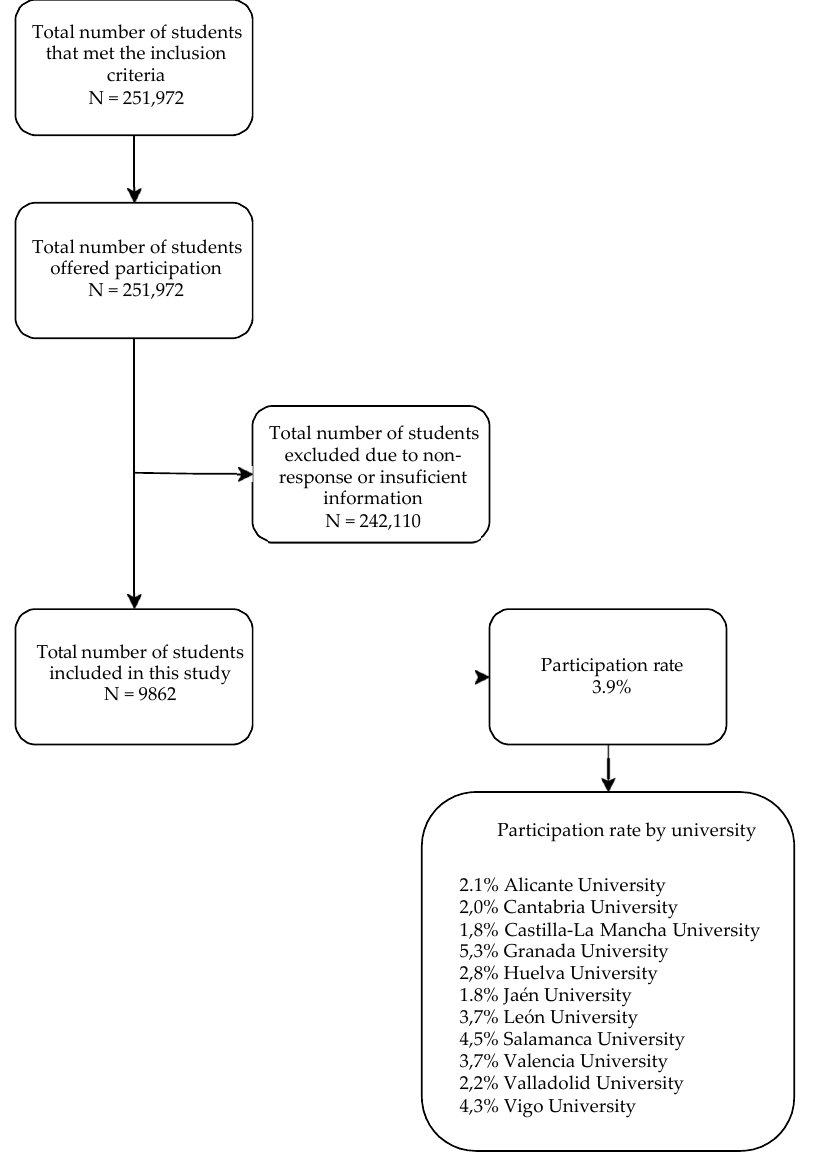
Figure 1. Recruitment flowchart (UniHcos project, 2018 Spain).